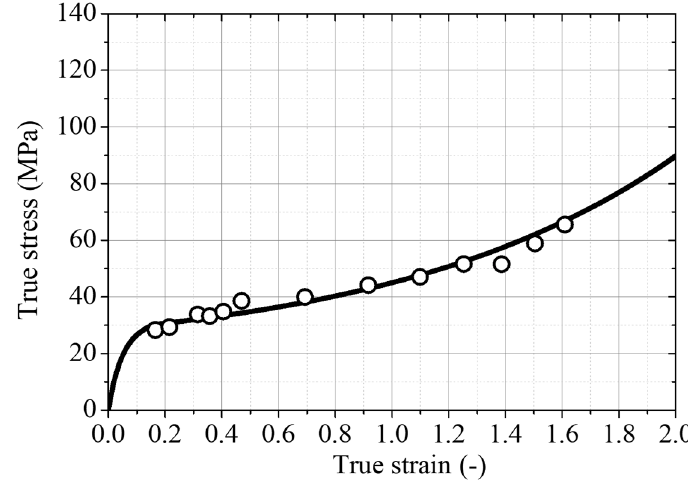
Figure 13. True stress–strain curve of PE 100 pipe grade resin.